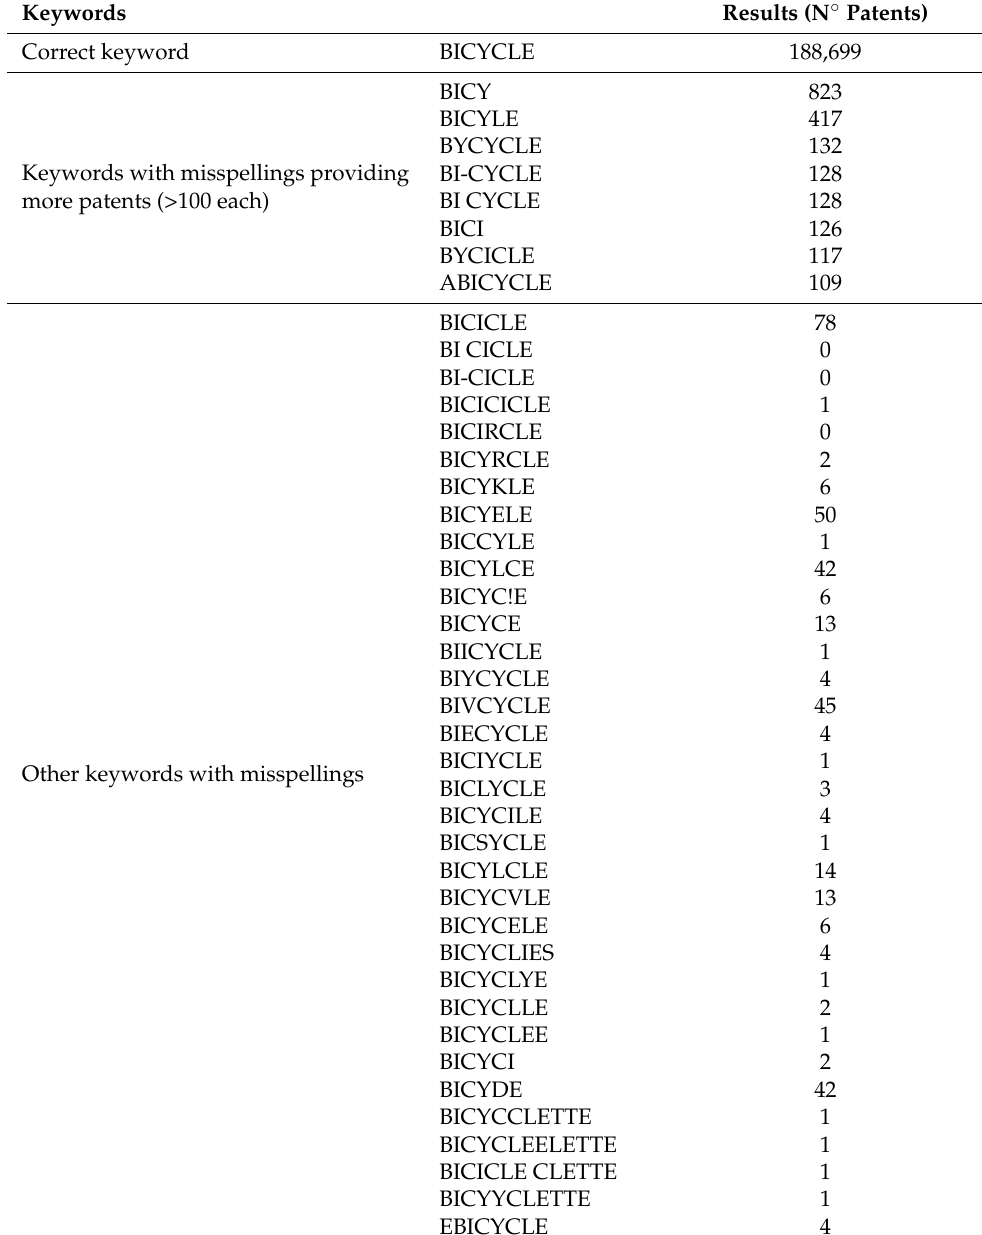
Table 6. Keywords (correct and with misspellings) used to search patents about BICYCLE.